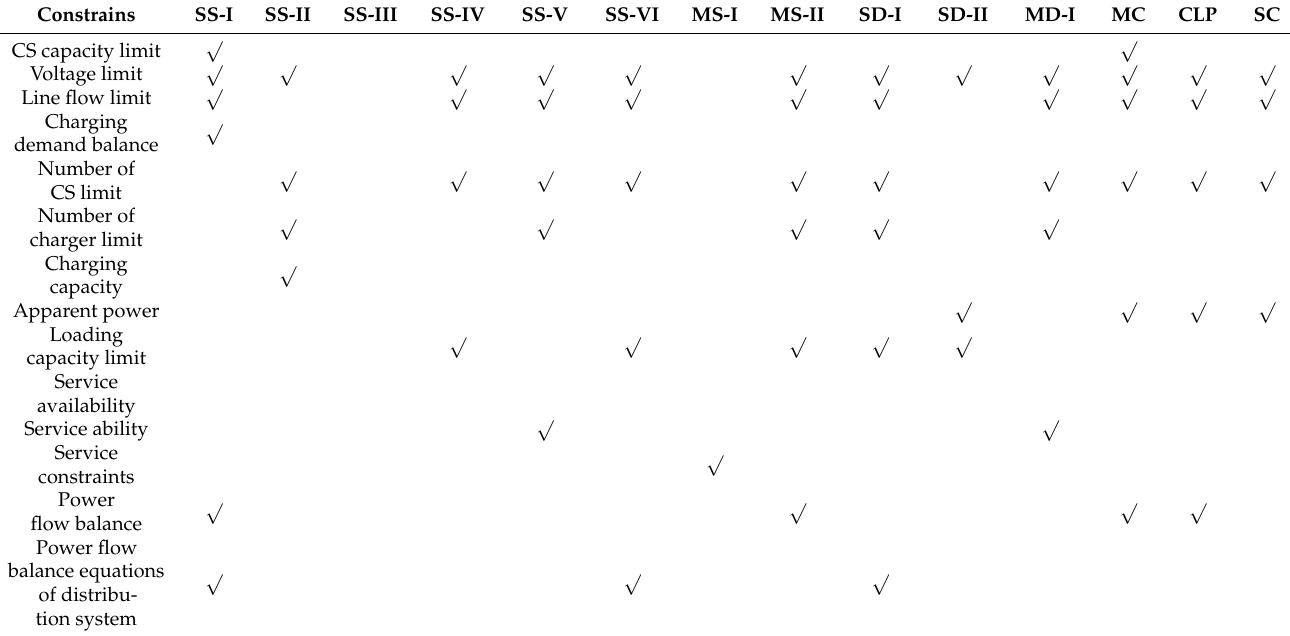
Table 8. Mapping between constraints and planning model.